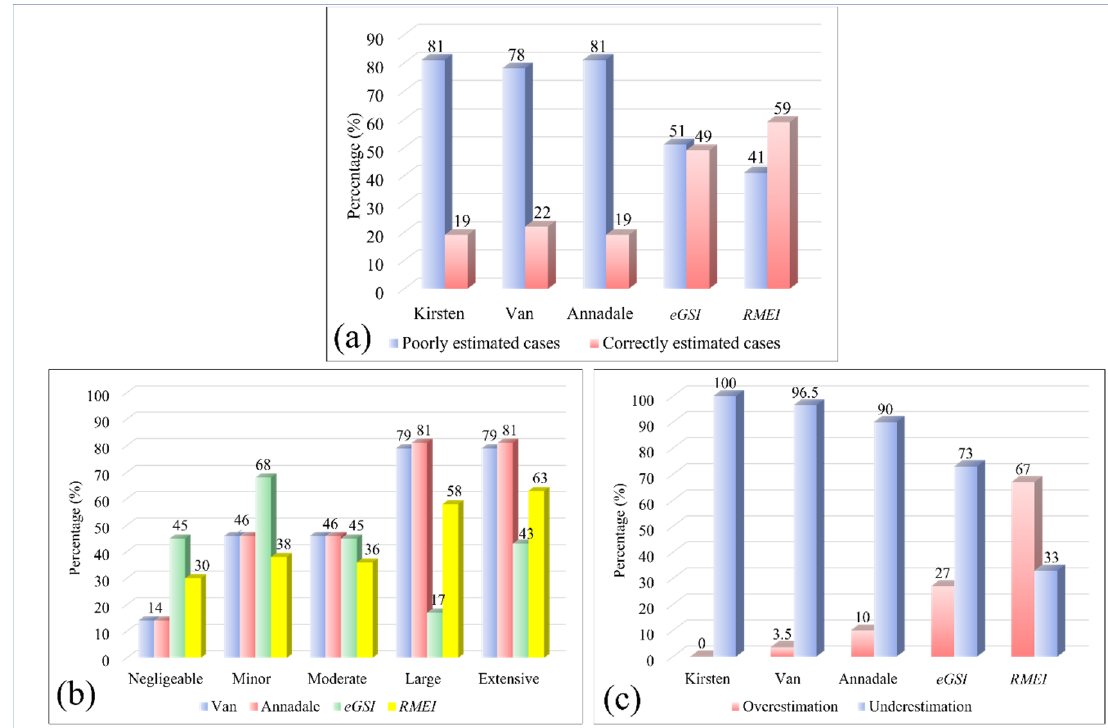
Figure 21. ( a ) The percentage of poorly estimated cases for each approach. ( b ) Committed errors of various methods according to different erosion classes. ( c ) Over- and underestimation rates of various semi-theoretical approaches.